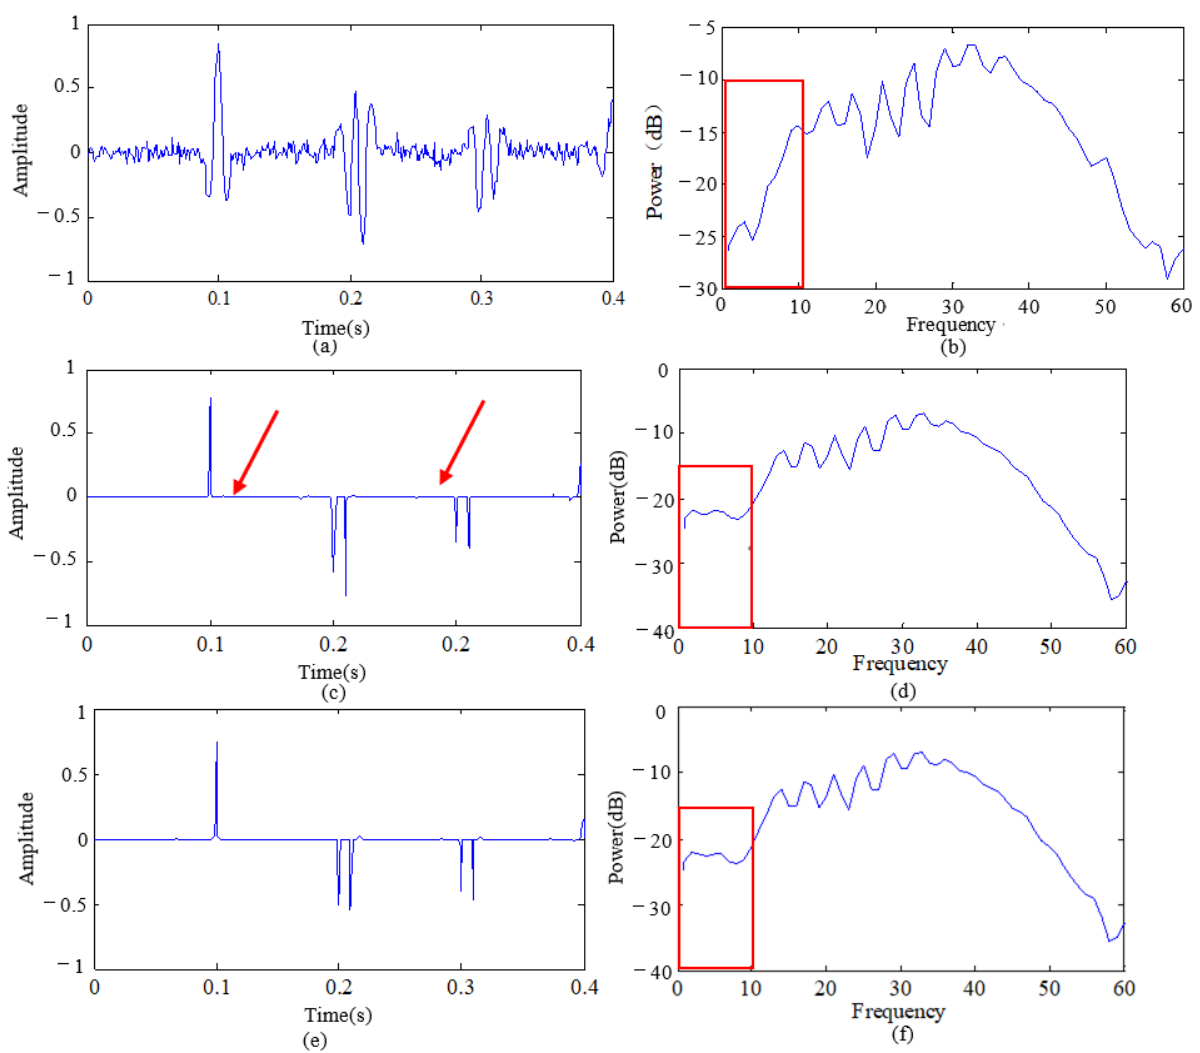
Figure 7. Comparisons of low-frequency expansion when SNR = 9.41. ( a , b ) Noisy data and their frequency spectrum, ( c , d ) reflection coefficients estimated by CS and extended spectrum, ( e , f ) reflection coefficients estimated by proposed method and extended spectrum.